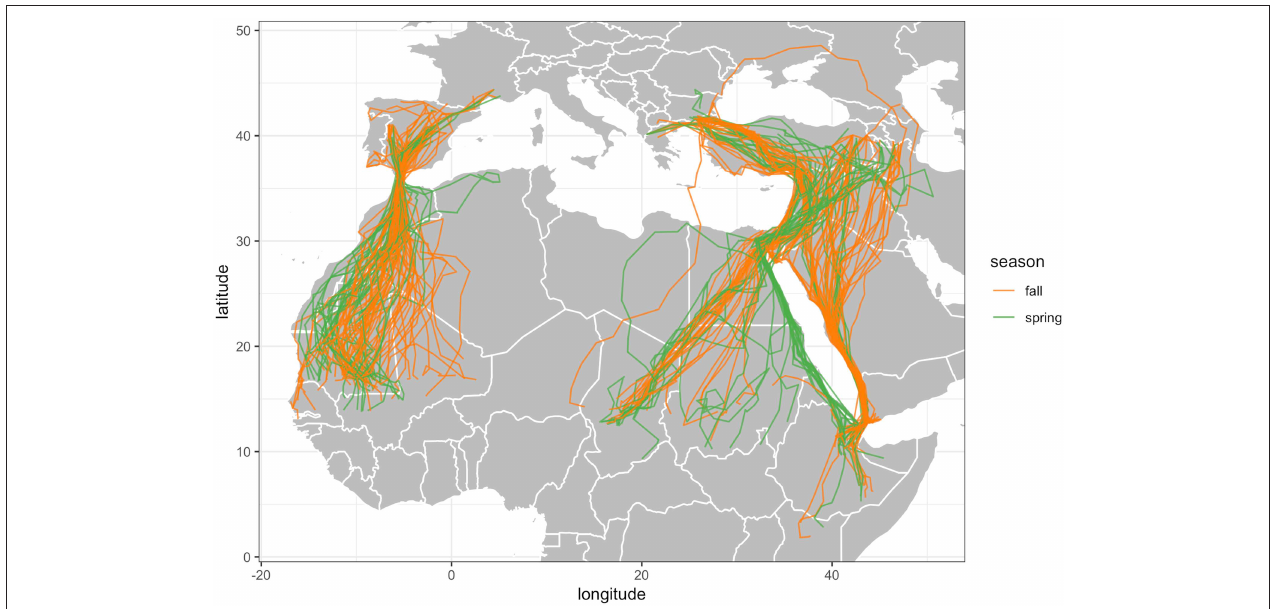
FIGURE 1 | Tracks of all 188 completed migrations of 60 individual Egyptian Vultures in both spring ( n = 71) and fall ( n =